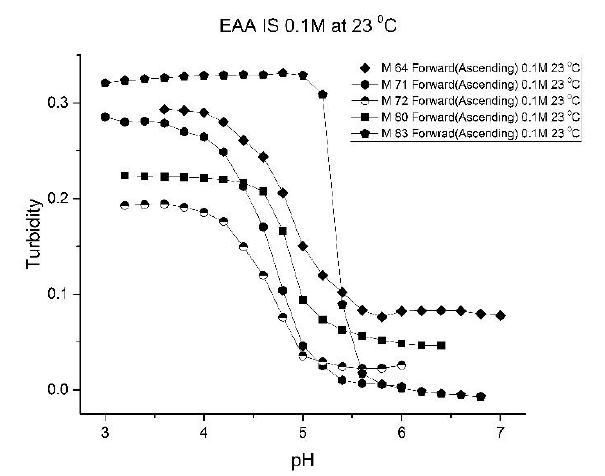
Figure 5. Ascending pH profiles at 23 °C for a variety of N -isopropylacrylamide copolymers of ethacrylic acid: M-64, M-71, M-72, M-80, and M-83.